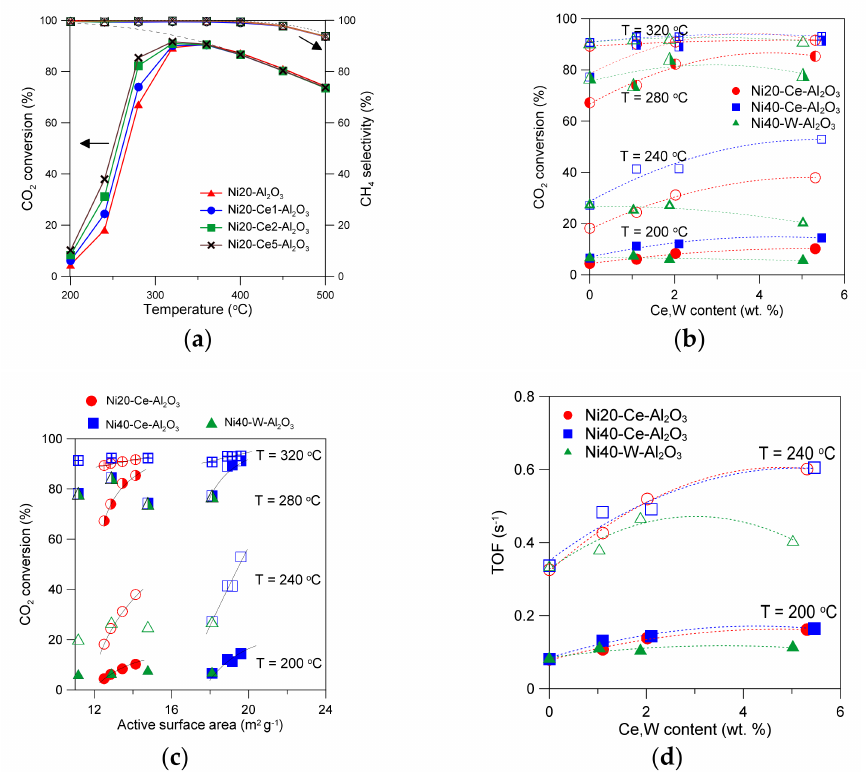
Figure 8. CO 2 conversion and selectivity to methane for alumina-supported catalysts promoted with Ce, containing 20 wt % Ni ( a ). Influence of catalyst composition on CO 2 conversion at selected temperatures ( b ). The effects of active surface area on CO 2 conversion ( c ). The influence of Ce or W content in catalysts on TOF values at selected temperatures ( d